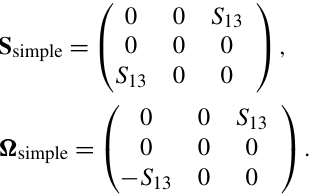
Figure 1. Segregated solver procedure for WJ-EARSM in Ellip- Sys3D. Note that P is the mean pressure, while P is the TKE shear